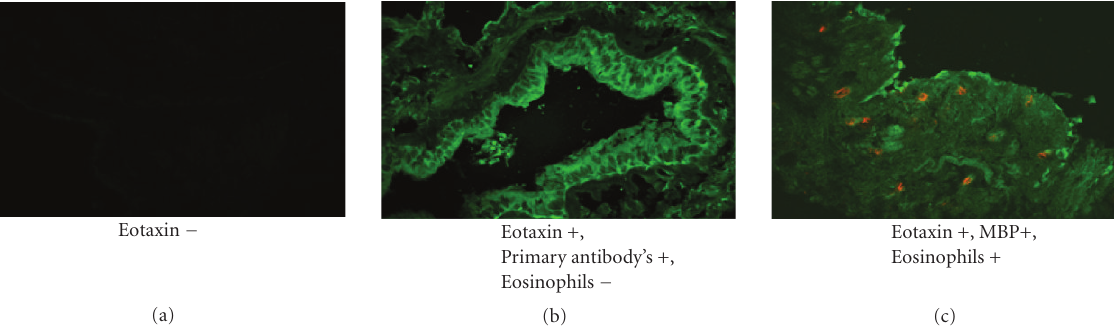
Figure 10: Eosinophils location and immunoreactive MBP and Eotaxin in human airway following overnight incubation with and without human eosinophils. Representative images of 2mm human airway incubated overnight with and without eosinophils. Immunoreactive eotaxin (green) and MBP (red) are shown. (a) shows absence of primary antibodies, (b) image shows epithelium and airway wall eotaxin (green), and (c) image shows epithelium and airway wall eotaxin (green) and MBP (red) (confocal microscopy